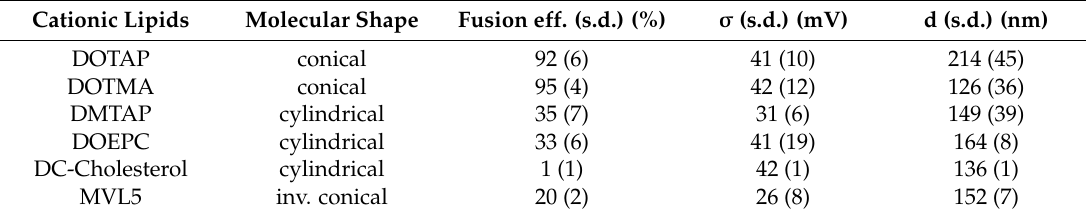
Table 1. Characteristics of FLs containing different cationic lipids: molecular shape of lipids, fusion efficiency of liposomes with CHO cells, zeta potentials ( σ ) and hydrodynamic sizes (d) of liposomes containing the respective cationic lipid, DOPE as helper lipid and BODIPY FL-DHPE as fluorescent molecule (1/1/0.1 mol/mol). Efficiencies of endocytosis and fusion give together 100%. Average values of at least three independent measurements and their standard deviations are